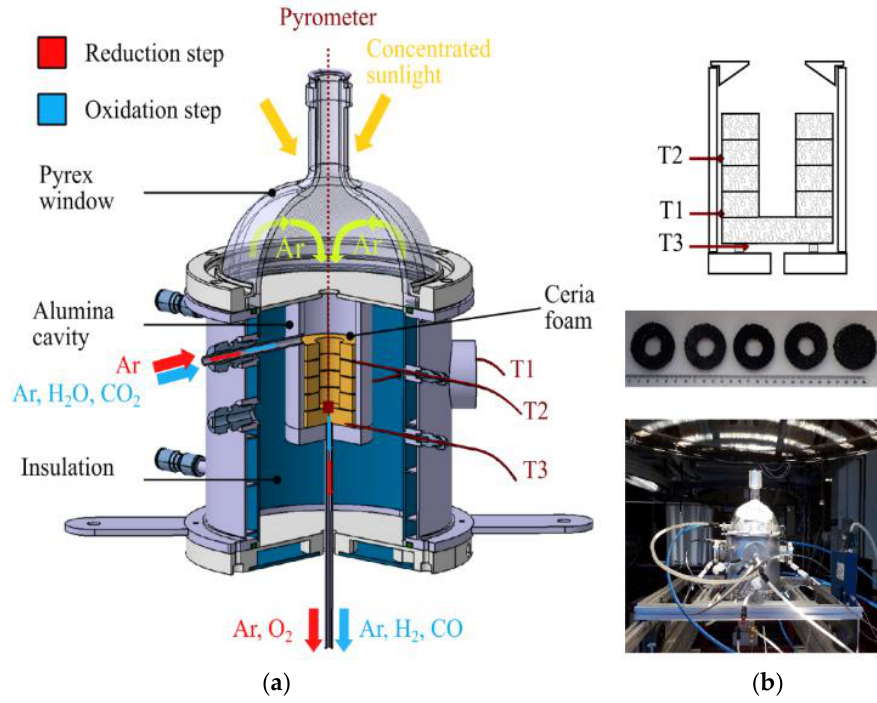
Figure 7. Solar redox cycling of ceria reticulated foams: ( a ) Scheme of the SUNFUEL solar reactor integrating reactive ceria foams for two-step H 2 O and CO 2 splitting; ( b ) Foam structure composed of a stack of disc and rings, and pictures after successive cycles performed with a CeO 2 foam under solar